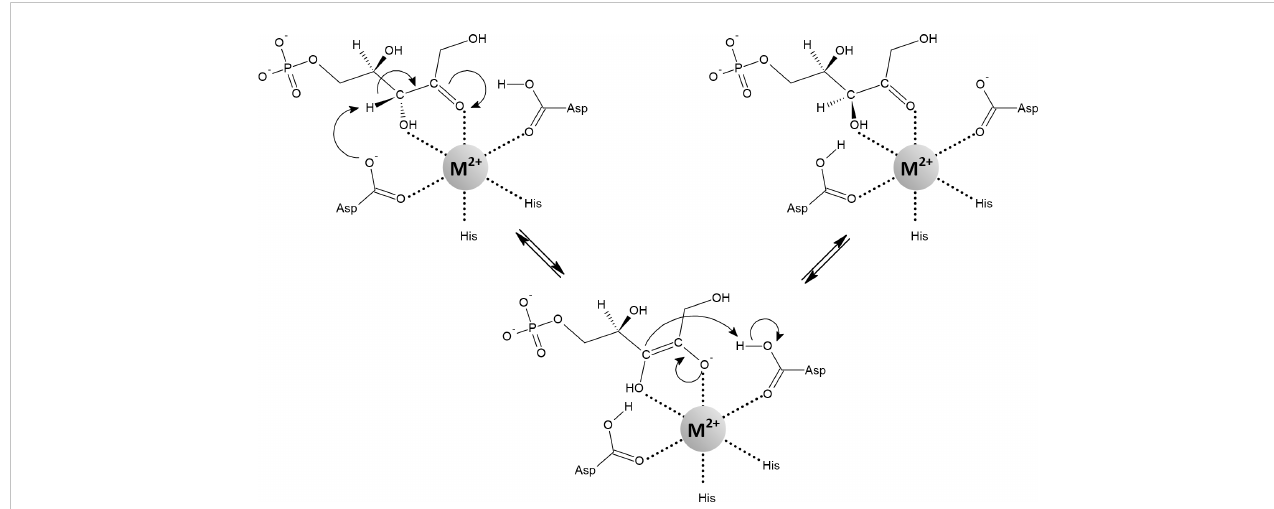
FIGURE 10 Mechanism of the reaction catalyzed by D -ribulose-5-phosphate 3-epimerase containing an octahedrally coordinated metal (Fe 2+ , Mn 2+ , Co 2+ ). The negatively charged cis -enediolate intermediate is stabilized by the metal ion in a bidentate manner. Depending on the organism and assay, various metals can activate the enzyme, including Zn 2+ . However, when Zn 2+ is used to metallate the enzyme, the active site tends to adopt a tetrahedral geometry. In such a case, it has been proposed that the substrate binds as a fi fth ligand in a monodentate manner, transiently forming a fi ve-coordinate geometry (Jelakovic et al., 2003; Akana et al., 2006; Caruthers et al., 2006; Liang et al., 2011; Sobota and Imlay,